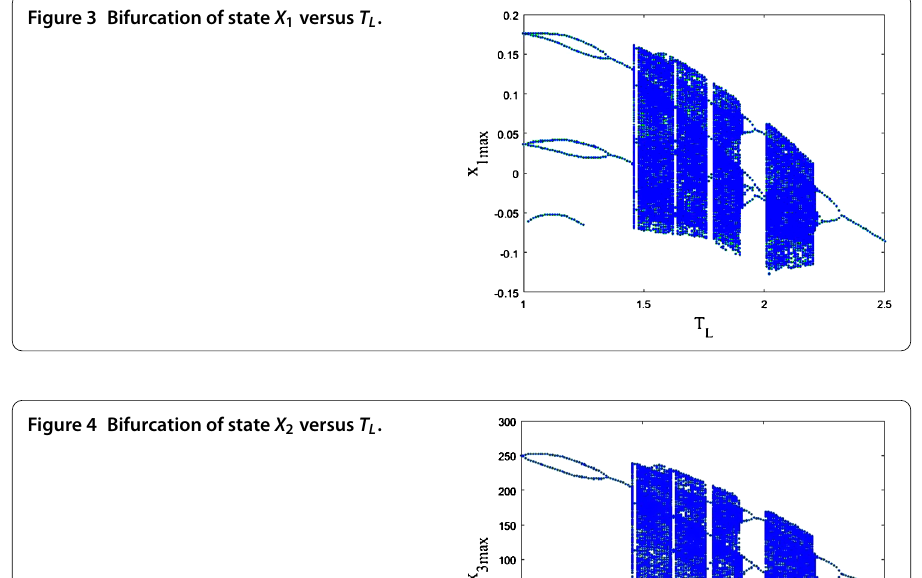
Figure 4 Bifurcation of state X 2 versus T L .